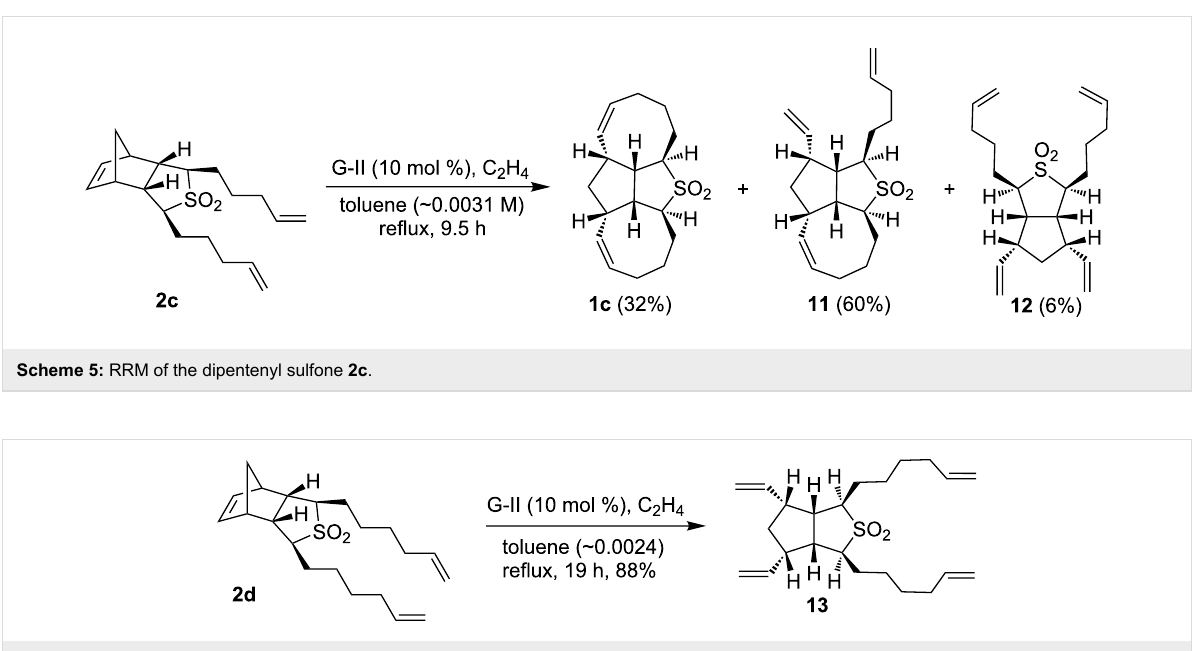
Scheme 6: RRM of the dihexenyl sulfone 2d